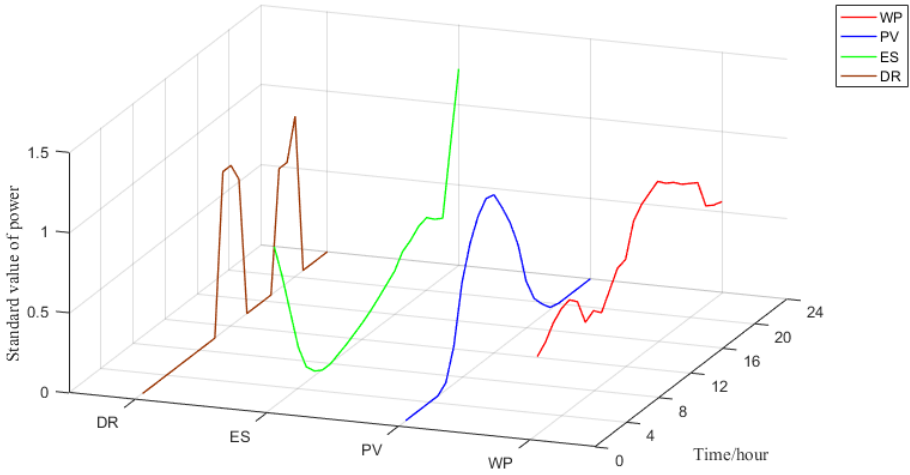
Figure 9. Distribution of distributed energy resources.